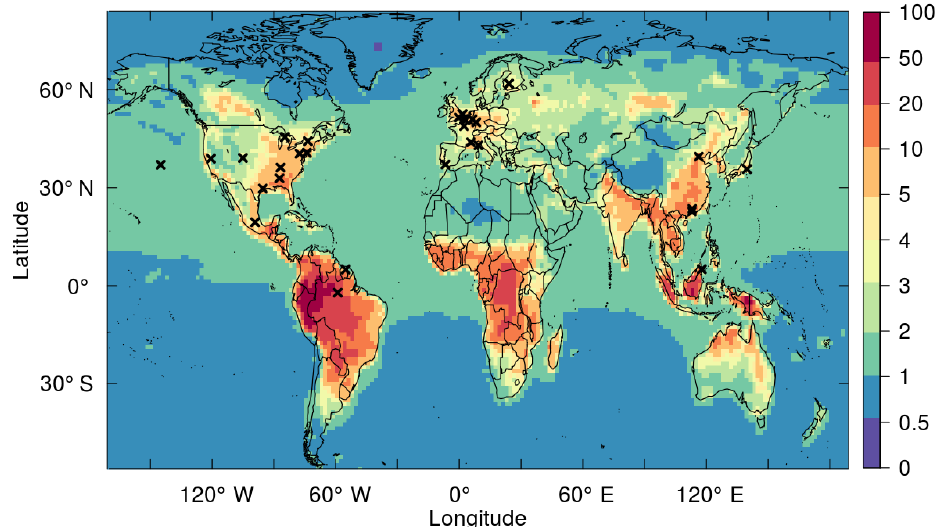
Figure 1. Annual mean of the total OH reactivity (in s − 1 ) calculated in the base run at the surface. Crosses indicate sites of field campaigns with which the model is